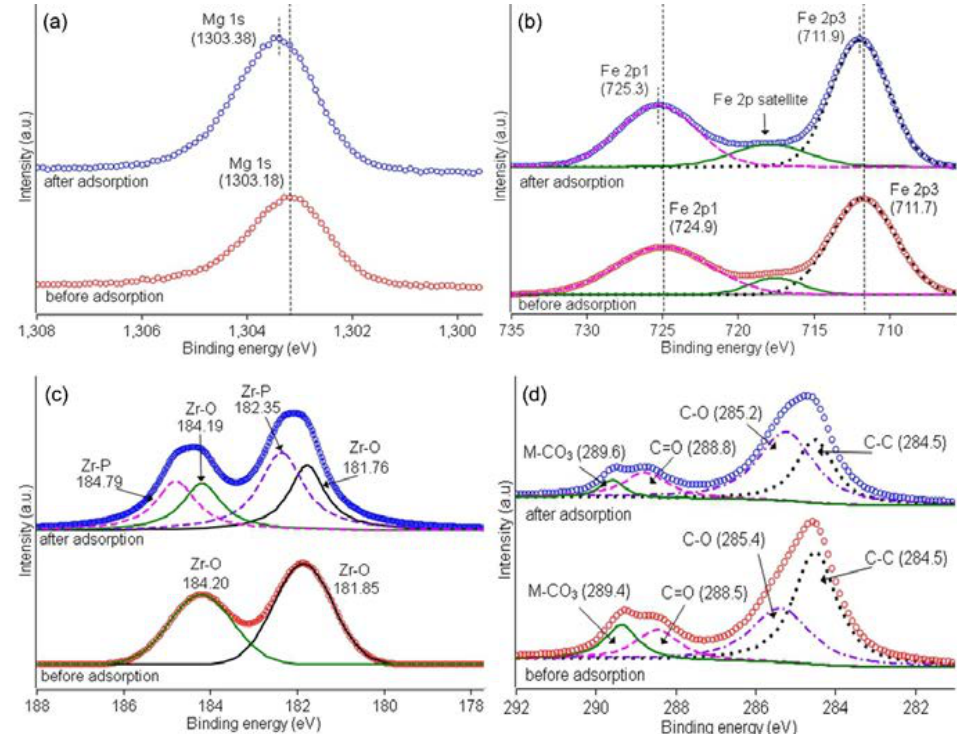
Fig. 7: XPS analysis of am-Zr/MgFe-LDH composite before and after phosphate adsorption: (a) Mg 1s, (b) Fe 2p, (c) Zr 3d, and (d) C 1s